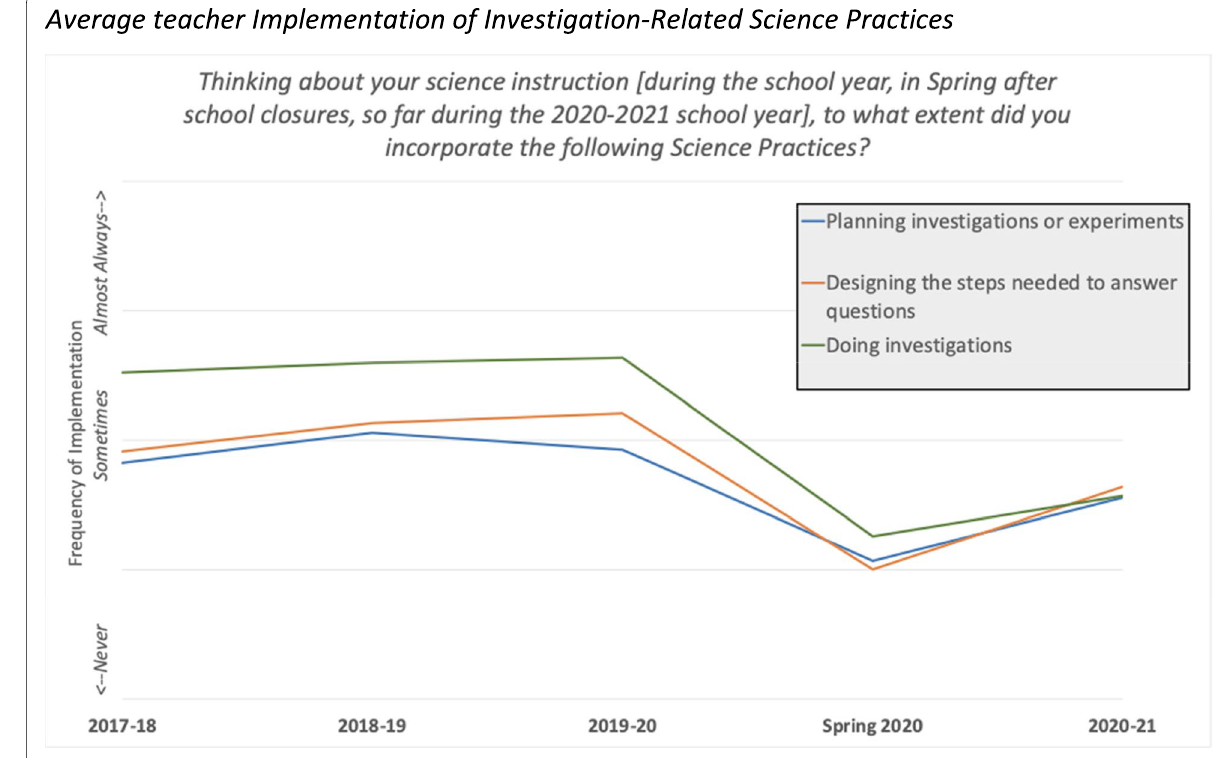
Fig. 5 Average teacher Implementation of Investigation-Related Science Practices